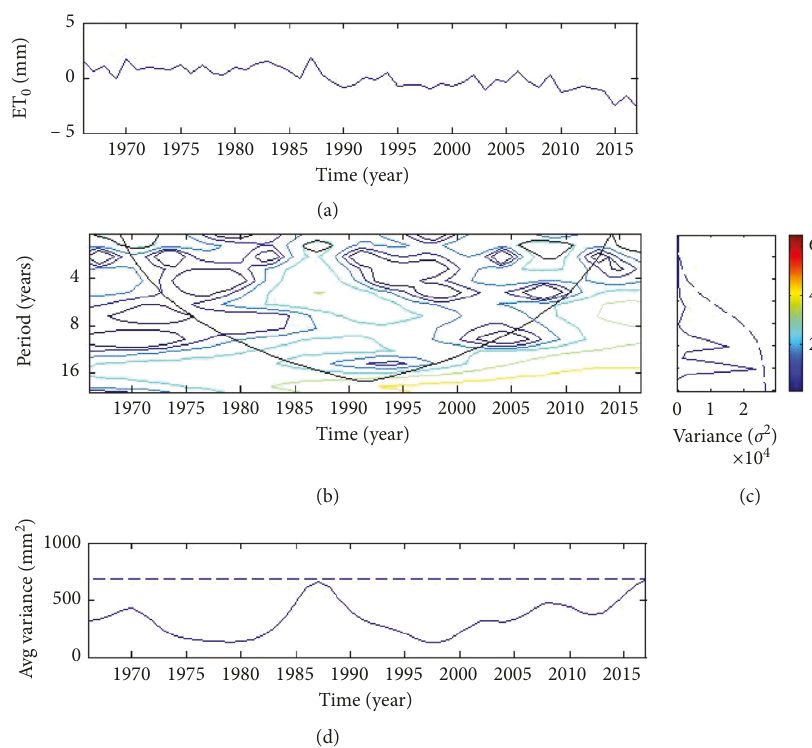
Figure 7: Morlet wavelet transformation of annual ET 0 from1965 to 2017 over Northeast China. (a) The ET 0 time series applied for the wavelet analysis. (b) The local wavelet power spectrum of (a). The thick black contour designates the 5% significance level against red noise and the cone of influence (COI) where edge effects might distort the picture is shown under a thin black curve. (c) Fourier power spectrum of annual ET 0 (solid). The dashed line is the 95% confidence spectrum. (d) Scale-averaged wavelet power over the 2–8 yr band for annual ET 0 (solid). The dashed line is 95% confidence level (The method cite from [35,